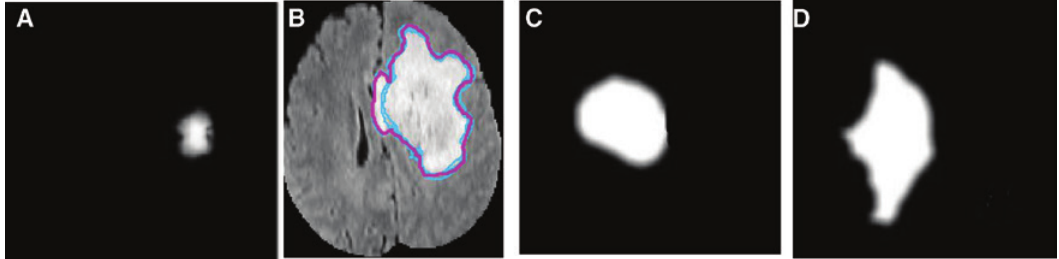
Figure 7: Ground Truth Datasets of Different Modalities.